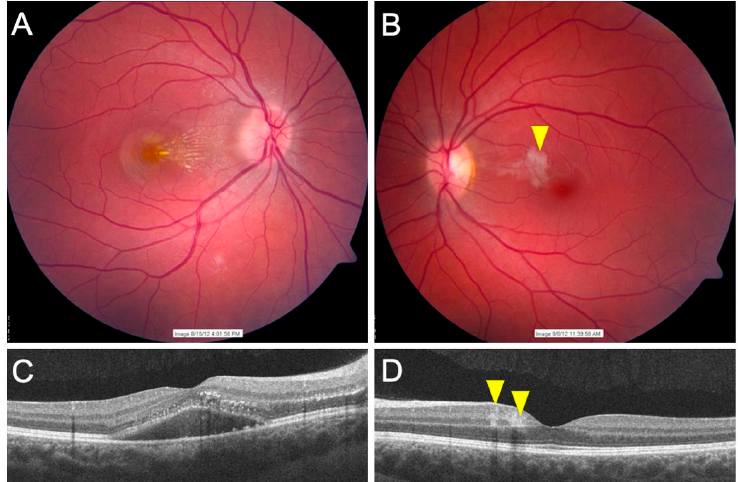
Figure 4. The figure shows a patient with cat-scratch disease (bartonella-related retinitis). Fundus photographs of the right and left eye ( A , B ) reveal the presence of neuroretinitis in the right eye and a branch retinal arteriole occlusion in the left eye (yellow arrowheads). The optical coherence tomography of both the eyes ( C , D ) does not show macular edema. However, there is significant subretinal fluid in the right eye ( C ). The left eye ( D ) shows hyperreflectivity in the inner retina (yellow arrowhead), suggestive of arteriolar occlusion.